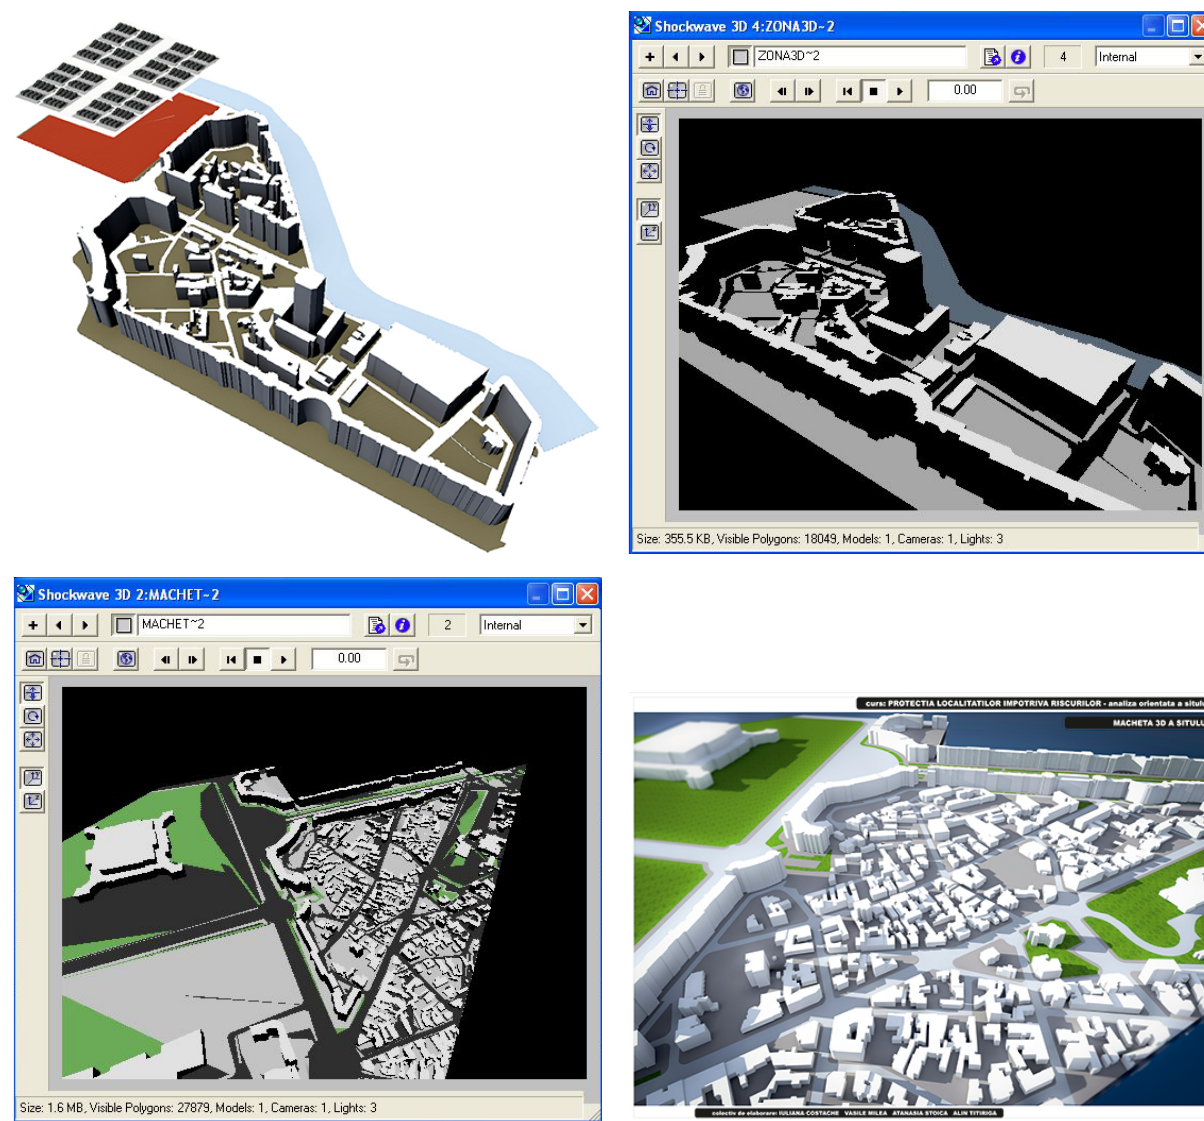
Fig. 1. CAD model of areas exposed to multi-hazard, destructured by former interventions in the communist time, a protected zone in Bucharest and their import in real time 3-D applications. The 3-D model helps to identify the free spaces in relationship with emergency housing. Above: Alexandra Chirloae, below: Iuliana Costache, Vasile Milea, Atanasia Stoica, Alin